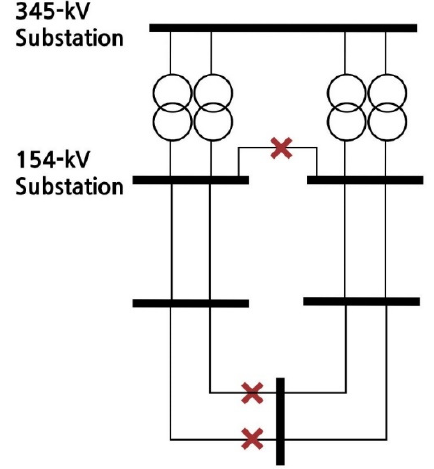
Figure 3. Line separation method with a sufficient transformer capacity.